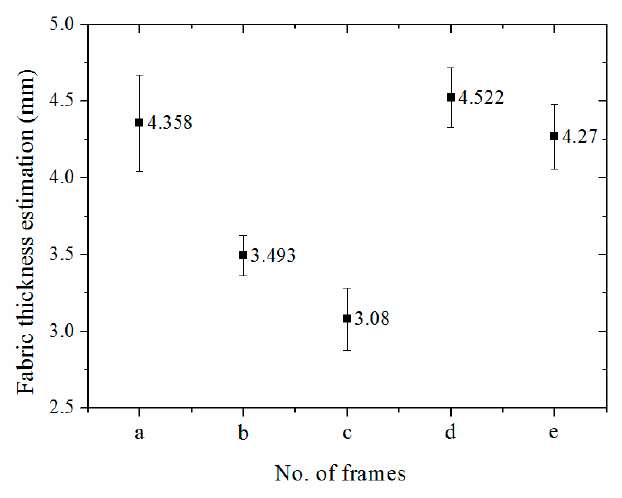
Figure 8. Fabric thickness estimation results.